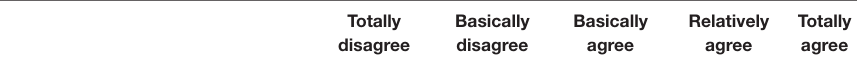
TABLE A1 | Questionnaire on influencing factors of physical